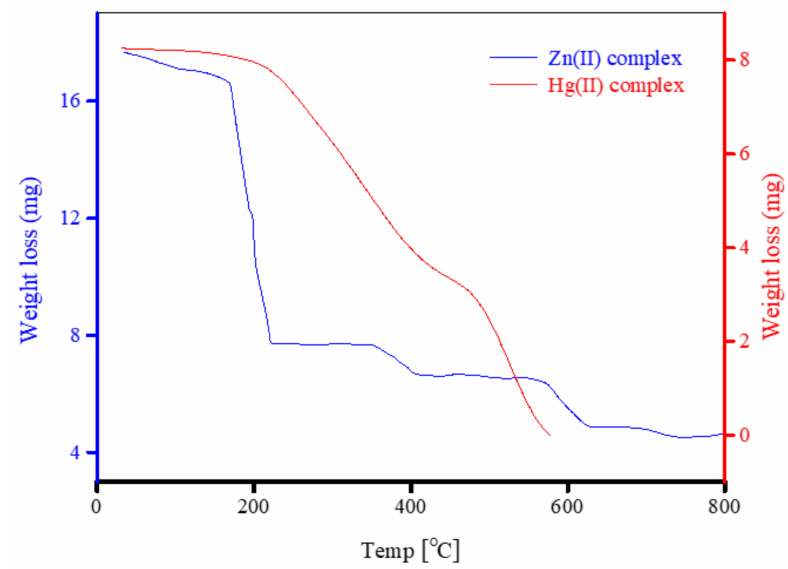
Figure 11. Thermograms of Zn 2+ and Hg 2+ complexes.